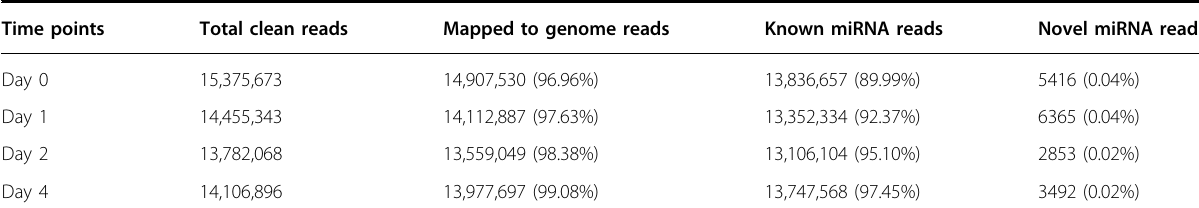
Table 1 Numbers of miRNA reads of C2C12 myoblast differentiation on days 0, 1, 2, and 4. Time points Total clean reads Mapped to genome